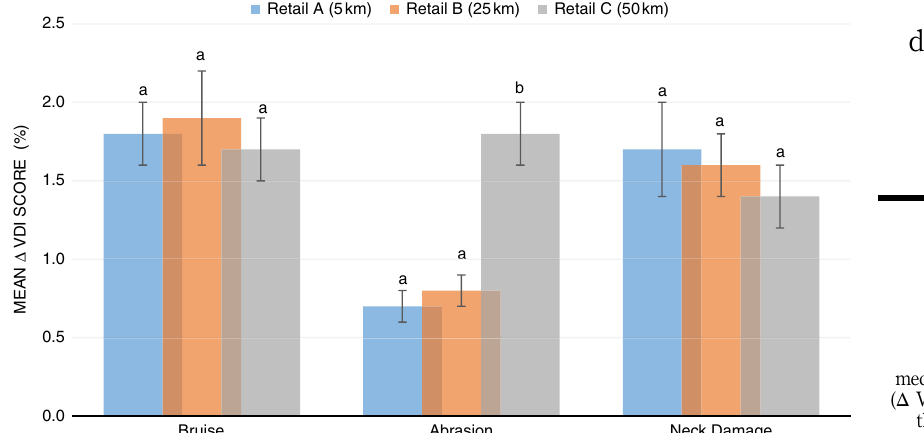
Figure 5. Increment of mechanical damages ( Δ VDI Score) during the distribution to three retails from